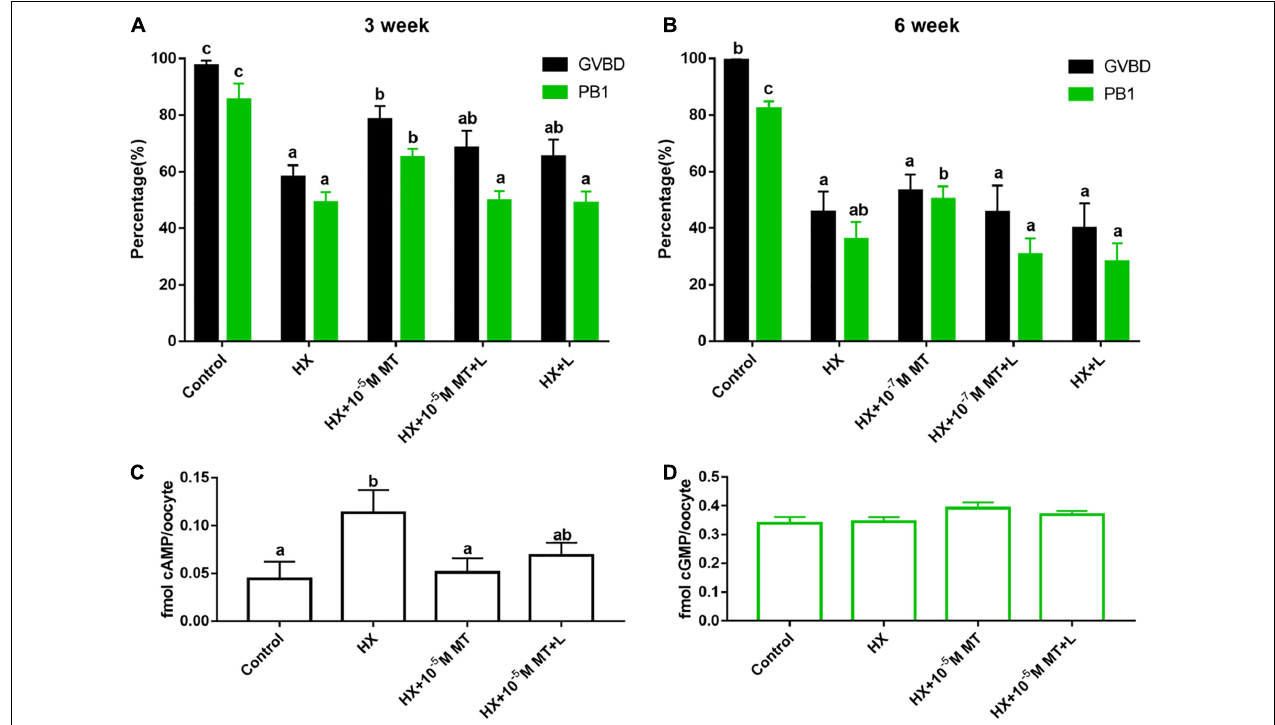
FIGURE 3 | Effects of melatonin receptors on the recovery of meiosis in mouse oocytes and the levels of cAMP and cGMP. (A) Three-week-old; control ( n = 119), HX ( n = 117), HX + 10 − 5 M MT ( n = 122), HX + 10 − 5 M MT + L ( n = 117), HX + L ( n = 120). (B) Six-week-old mice: control ( n = 100), HX ( n = 100), HX + 10 − 7 M MT ( n = 104), HX + 10 − 7 M MT + L ( n = 99), and HX + L ( n = 104). (C,D) Effects of luzindole on cAMP and cGMP levels in oocytes. Levels of cAMP and cGMP in oocytes from different groups were tested by ELISA. (C) cAMP: Control ( n = 419), HX ( n = 416), HX + 10 − 5 M MT ( n = 425), HX + 10 − 5 M MT + L ( n = 419). (D) cGMP: Control ( n = 320), HX ( n = 320), HX + 10 − 5 M MT ( n = 320), HX + 10 − 5 M MT + L ( n = 310). HX, 4 mM hypoxanthine; MT, melatonin; L, 10 − 7 M luzindole. Data represent the mean with SEM. Different superscript letters (a–d) in each column represent significant differences vs respective groups. ( P < 0.05) determined by one-way ANOVA followed by Tukey post hoc